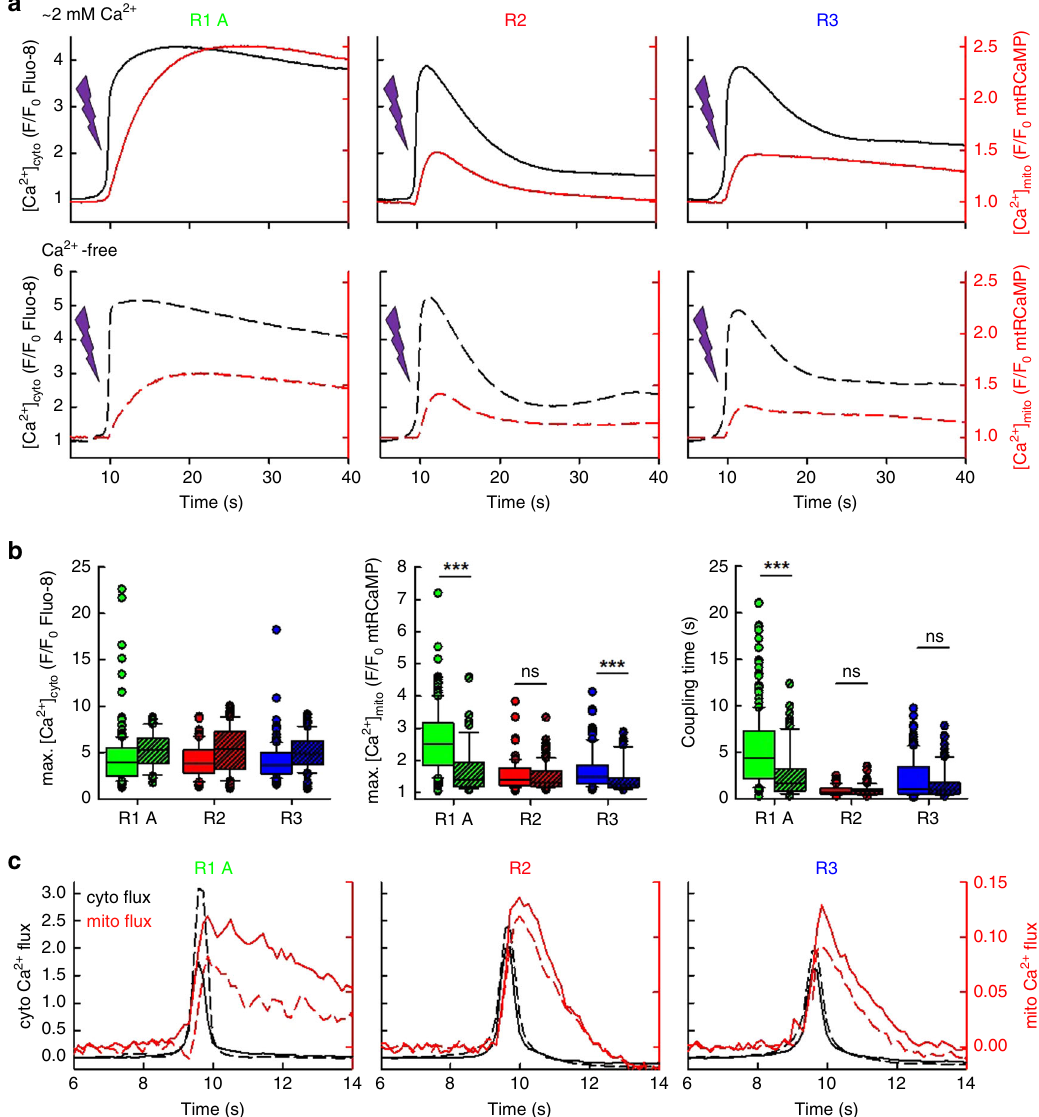
Fig. 5 IP3R2 couples mitochondria best to IP 3 -induced Ca 2 + signal. a DT40 cells were transfected with mtRCaMP then loaded with caged IP 3 and fl uo8/ AM. Calcium signals were evoked by photo-uncaging of IP 3 (lightning bolts). [Ca 2 + ] cyto and mitochondrial [Ca 2 + ] mito signals were measured simultaneously in individual cells. Synchronized, mean Ca 2 + signals in the presence (top row, N = 215, 91, and 131 cells, for R1A, R2, R3, respectively, from three independent experiments) and absence (bottom row, N = 77, 95, and 83 cells, respectively, for R1A, R2, R3) of Ca 2 + in the extracellular medium. b Box plots show quanti fi cation of maximal [Ca 2 + ] cyto , maximal [Ca 2 + ] mito signals and coupling times compared in the presence and absence (dashed bars) of Ca 2 + in the extracellular medium (median line, box: 25 – 75%, error bars 10 – 90% and individual outliers as dots). *** p < 0.001 with Mann – Whitney extracellular medium. Source data are provided for panel b as a Source Data fi